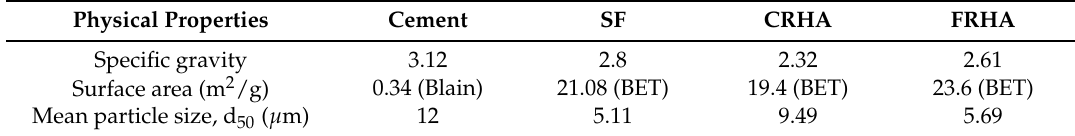
Table 3. Physical properties of cement, SF, CRHA, and FRHA.